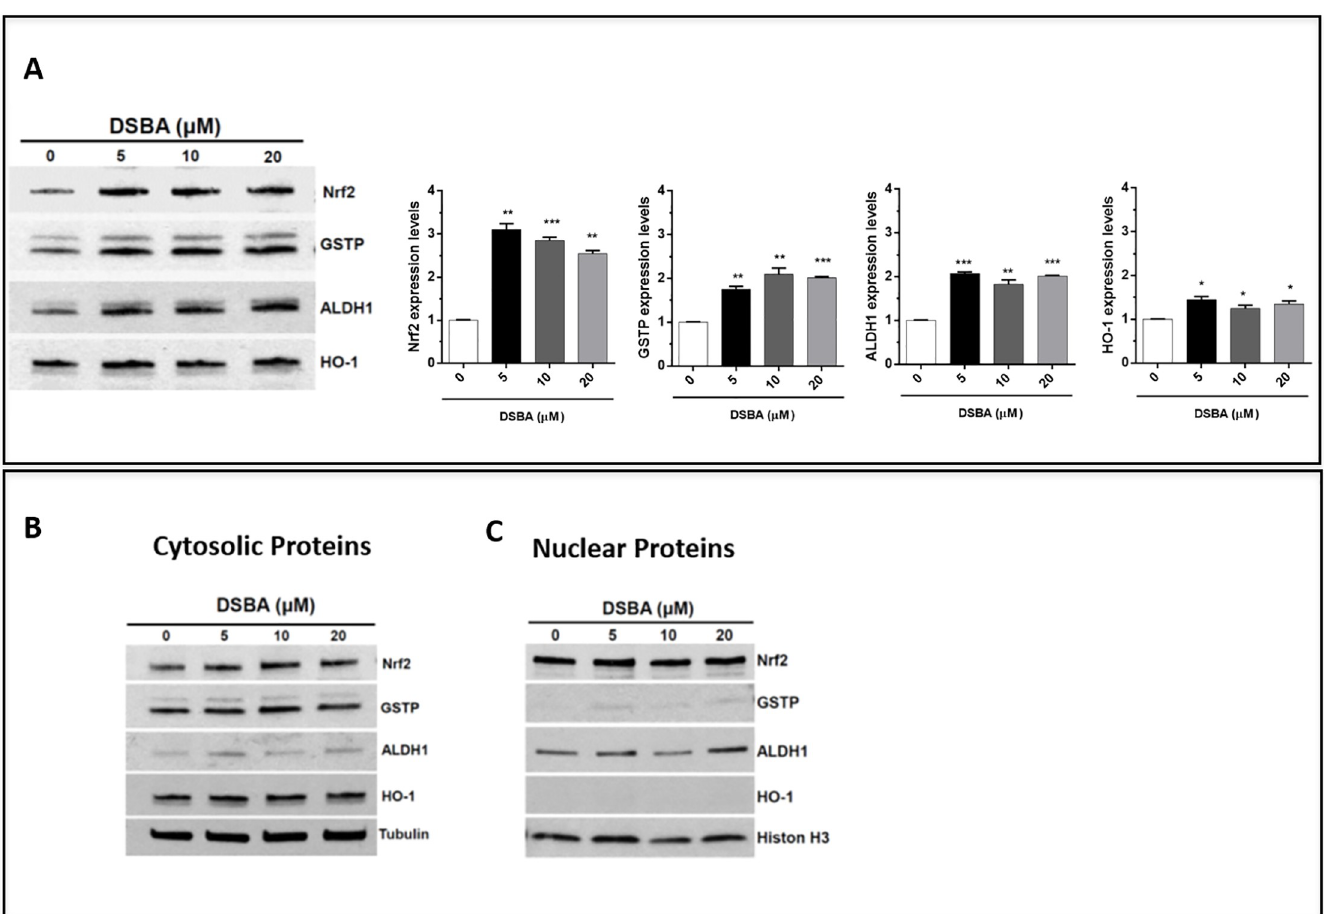
Fig 5. Activation and nuclear translocation of Nrf2 in DSBA-treated BM-MNCs. BM-MNCs were treated for 4h with DSBA at increasing concentrations from 5 to 20 μ M and levels of Nrf2 protein and the Nrf2-dependent genes HO-1, ALDH1, and GSTP were assessed by immunoblotting in cellular extracts before (A) or after fractionation of cytosolic (B) and nuclear components